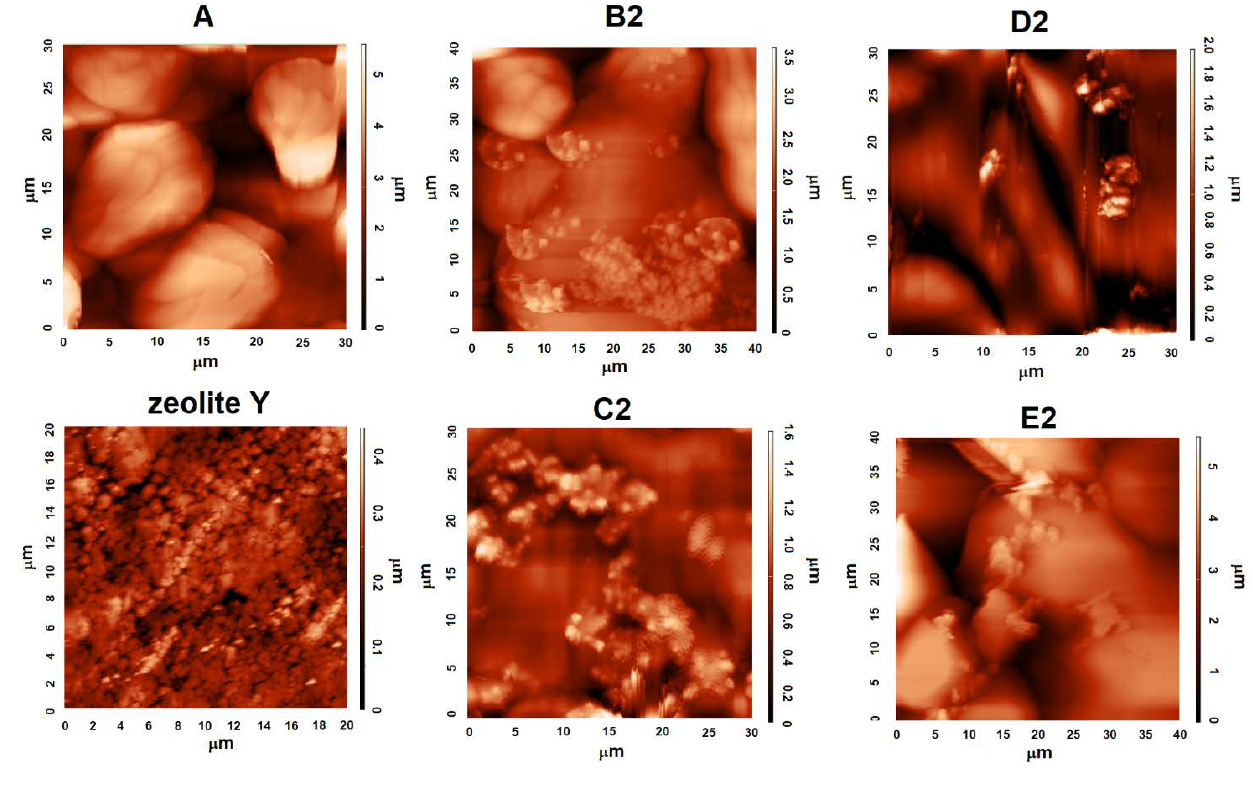
Figure 3. AFM images of the surface of ANFO samples.